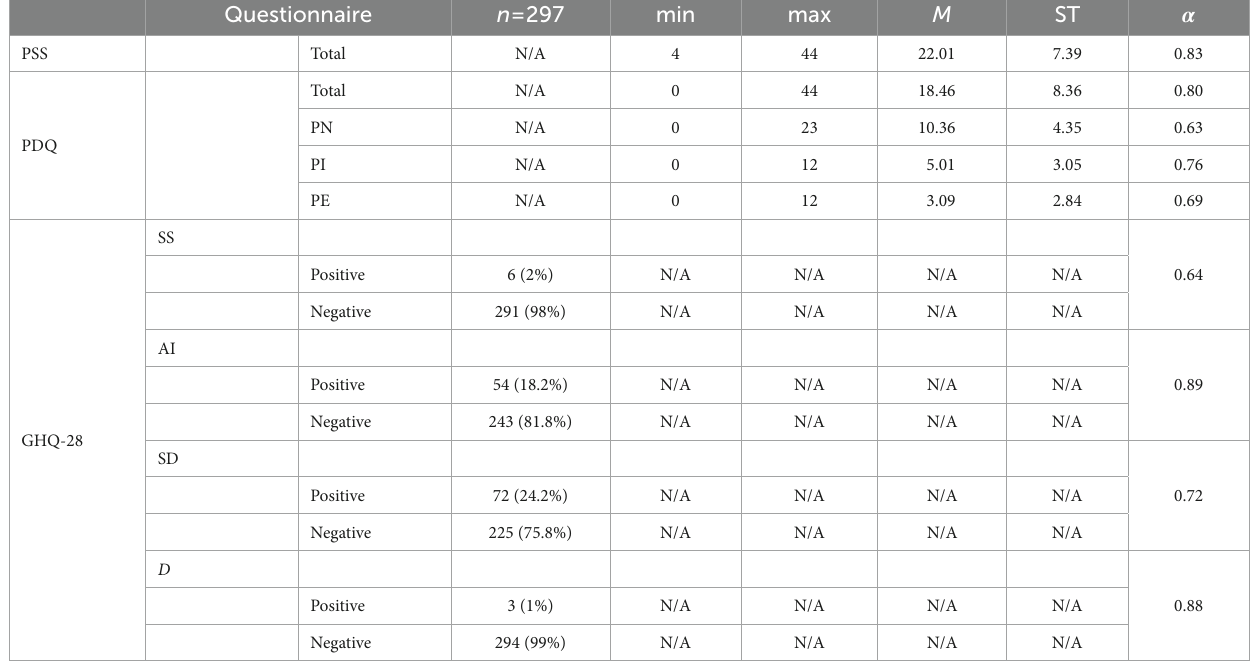
TABLE 2 Descriptive statistics of self-perceived stress, prenatal distress and general health.